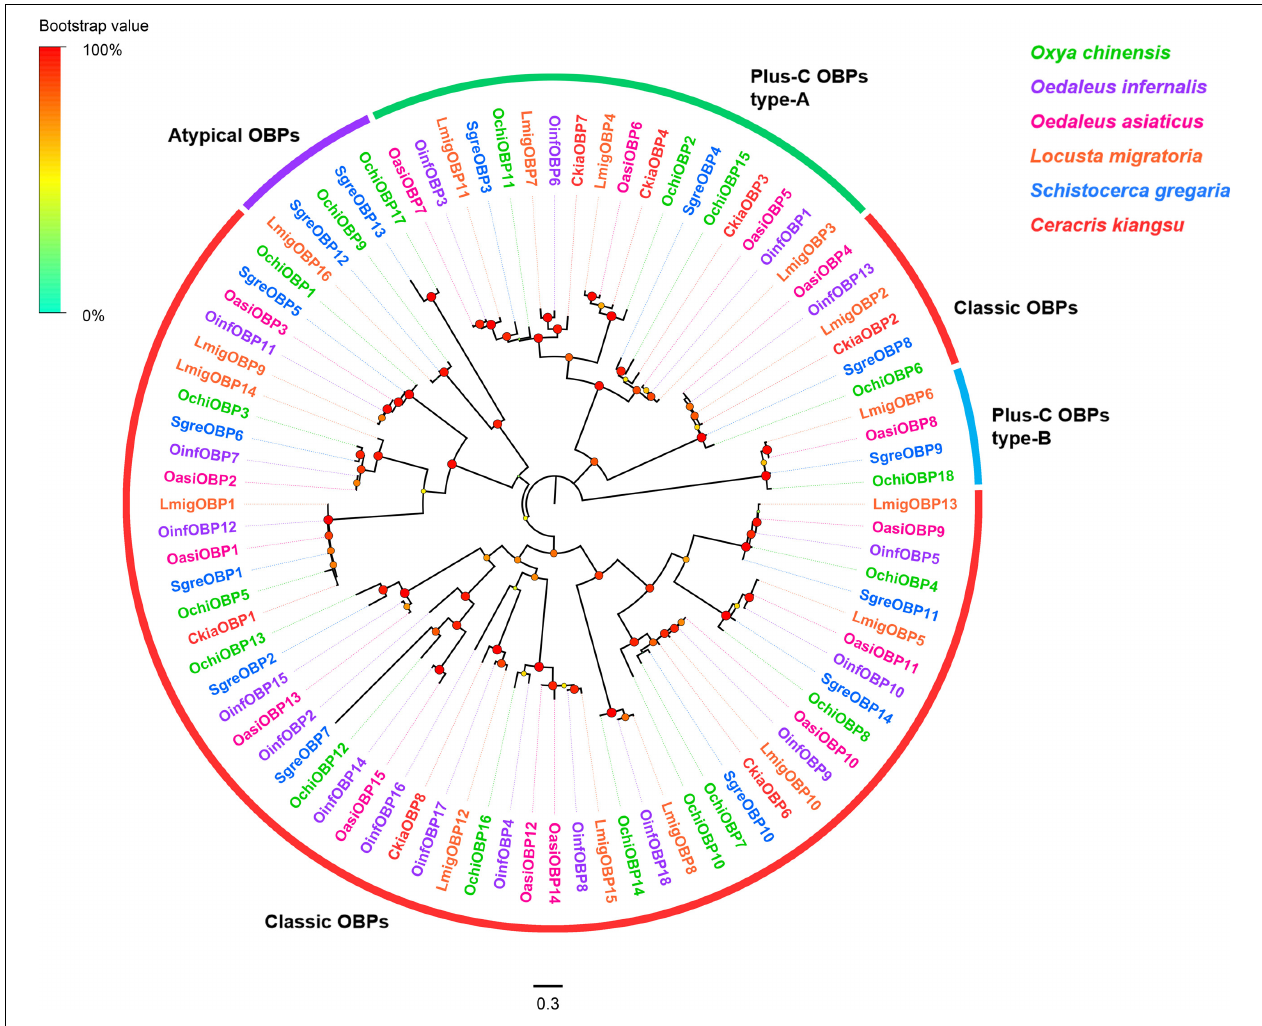
FIGURE 1 | Phylogenetic tree of putative odorant-binding proteins (OBPs). Branch support (circles at the branch nodes) was estimated using an approximate likelihood ratio test based on the scale indicated on the top left. Bars indicate branch lengths in proportion to amino acid substitutions per site. Classic OBPs are in red; plus-C OBPs type-A in green; plus-C OBPs type-B in blue; and atypical OBPs in purple.